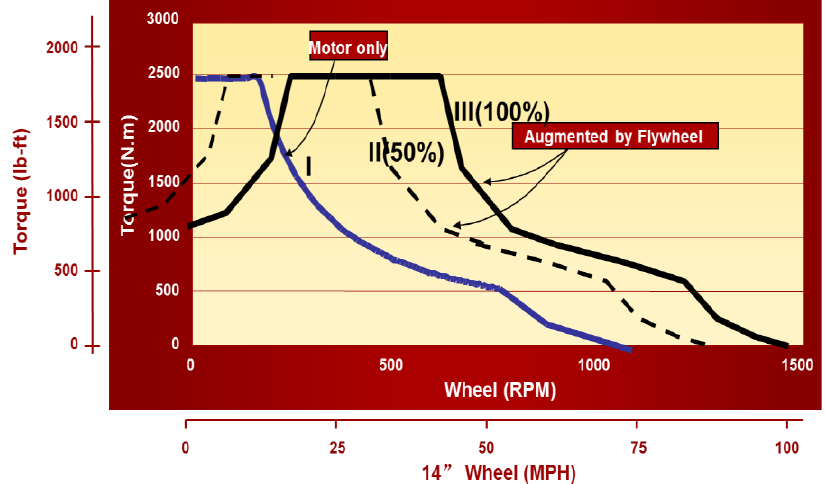
Figure 3. Dynamic external characteristics of the flywheel power system.